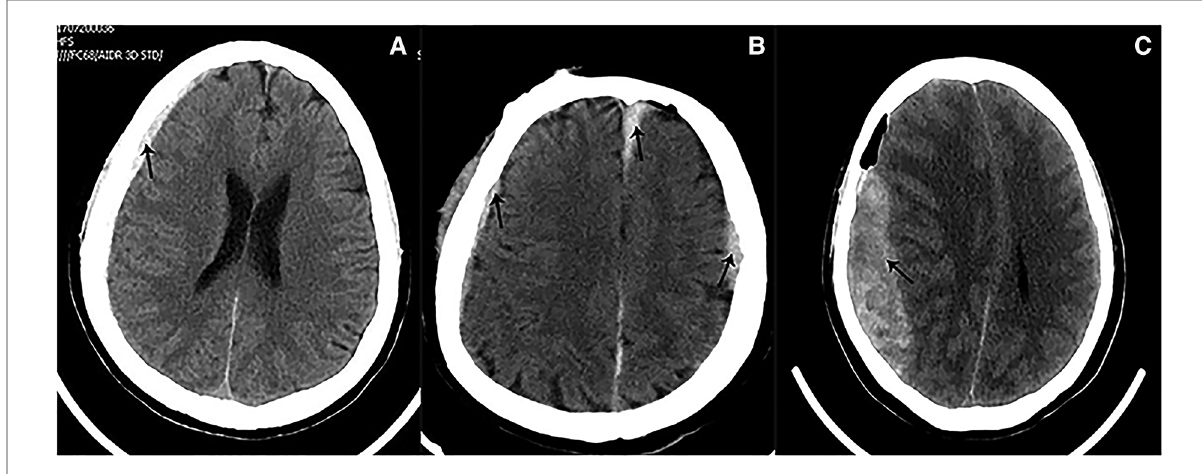
FIGURE 4 Postoperative imaging of patients with SDH. ( A ) Postoperative CT in a patient with left HFS showed a right frontal SDH (black arrow). ( B ) Postoperative CT in a patient with left HFS showed multiple sites of SDH (black arrow), involving bilateral temporal lobes and the cerebral falx. ( C ) Postoperative CT on a patient with right TN showed that a massive right temporal SDH (black arrow) lead to the displacement of the